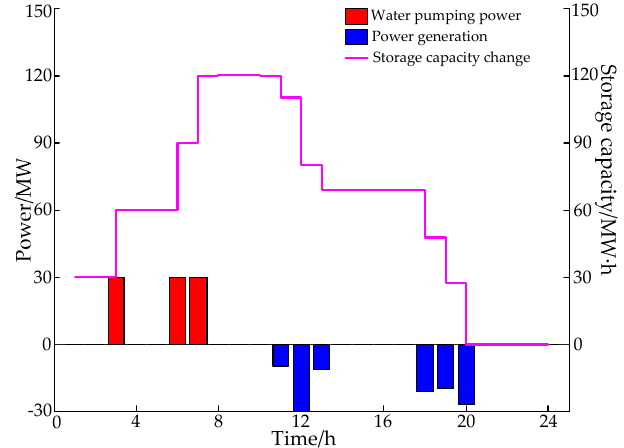
Figure 16. Changes of pumping and generating power and storage capacity of the PSPS.